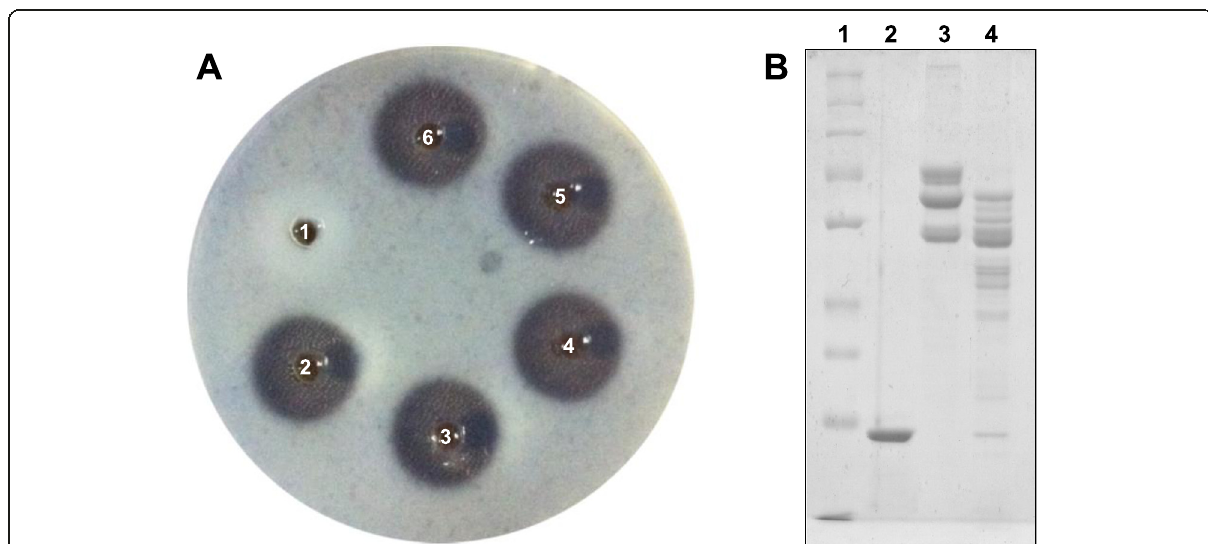
Fig. 8 Fibrin(ogen)olytic activity of the MP isolated from B. atrox venom. a Evaluation of the fibrinolytic activity on fibrin gel. Samples were applied on plates containing fibrin gels, and incubation was performed at 37 °C for 24 h. Samples (halo diameter): 1. PBS (0 mm), 2. B. atrox venom 20 μ g (15 mm), 3. MP 4 μ g (15 mm), 4. MP 6 μ g (15.5 mm), 5. MP 8 μ g (16 mm), 6. MP 10 μ g (16.5 mm). b Evaluation of the fibrinogenolytic activity by SDS-PAGE. Samples were incubated at 37 °C for 1 h and then evaluated on 10 % polyacrylamide gel under denaturing conditions. Lanes: 1 Molecular mass standard (260, 140, 100, 70, 50, 40, 35, 25, 15 kDa), 2. MP 5 μ g, 3. Fibrinogen 25 μ g, 4. Fibrinogen 25 μ g + MP 1 μ